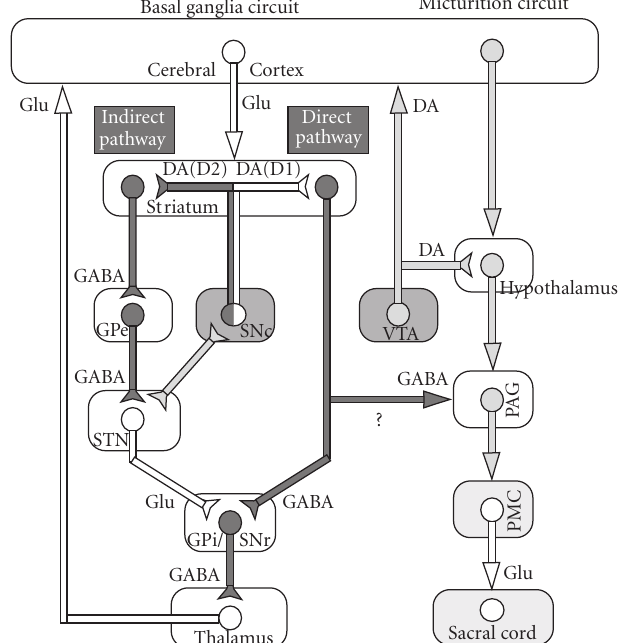
Figure 2: Possible relationship between basal ganglia circuit (left side) and micturition circuit (right side; modified from Sakakibara et al. [39]). DA, dopamine; GABA, gamma-aminobutyric acid; SNc, substantia nigra pars compacta; GPi, globus pallidus internus; SNr, substantia nigra pars reticulate; STN, subthalamic nucleus; GPe, globus pallidus externus; VTA, ventral tegmental area; PMC, pontine micturition centre; Glu, glutamate; black line, inhibitory neurons; white line, excitatory neurons; hatched line, neurons of undetermined property. The micturition reflex (right-side pathway) is under the influences of dopamine (DA; both inhibitory in D1 and facilitatory in D2) and gamma- aminobutyric acid (GABA; inhibitory). The substantia nigra pars compacta (SNc) neuronal firing and the released striatal dopamine seem to activate the dopamine D1-GABAergic direct pathway , which not only inhibits the basal ganglia output nuclei (e.g., the globus pallidus internus (GPi), substantia nigra pars reticulata (SNr)), but also may inhibit the micturition reflex via GABAergic collateral to the micturition circuit. High-frequency stimulation (leading to inhibition) in the subthalamic nucleus (STN) also results in bladder inhibition. See text.